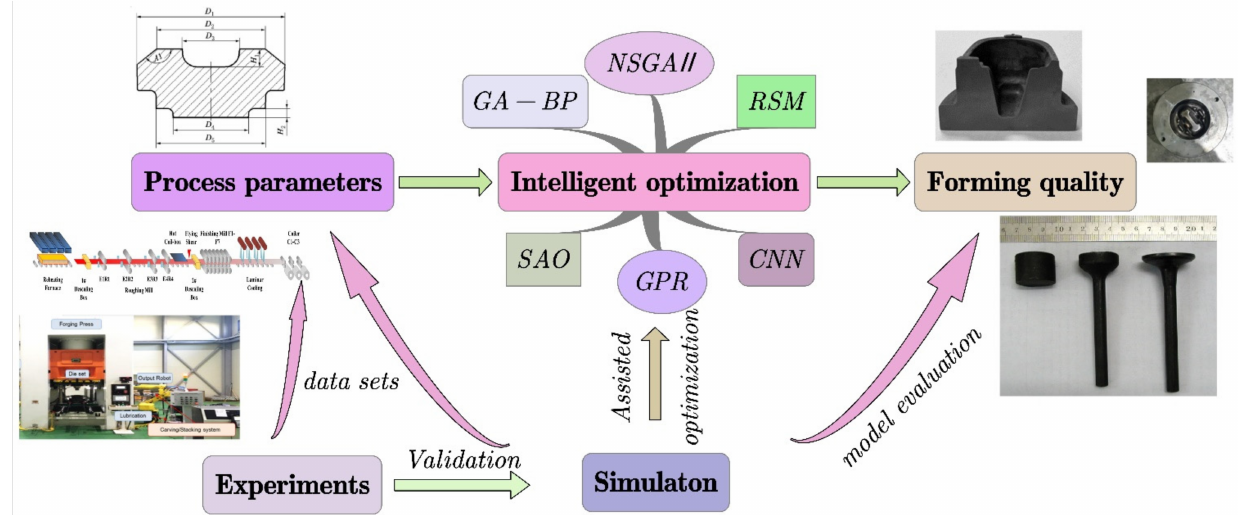
Figure 1. The framework for intelligent optimization of forming quality and